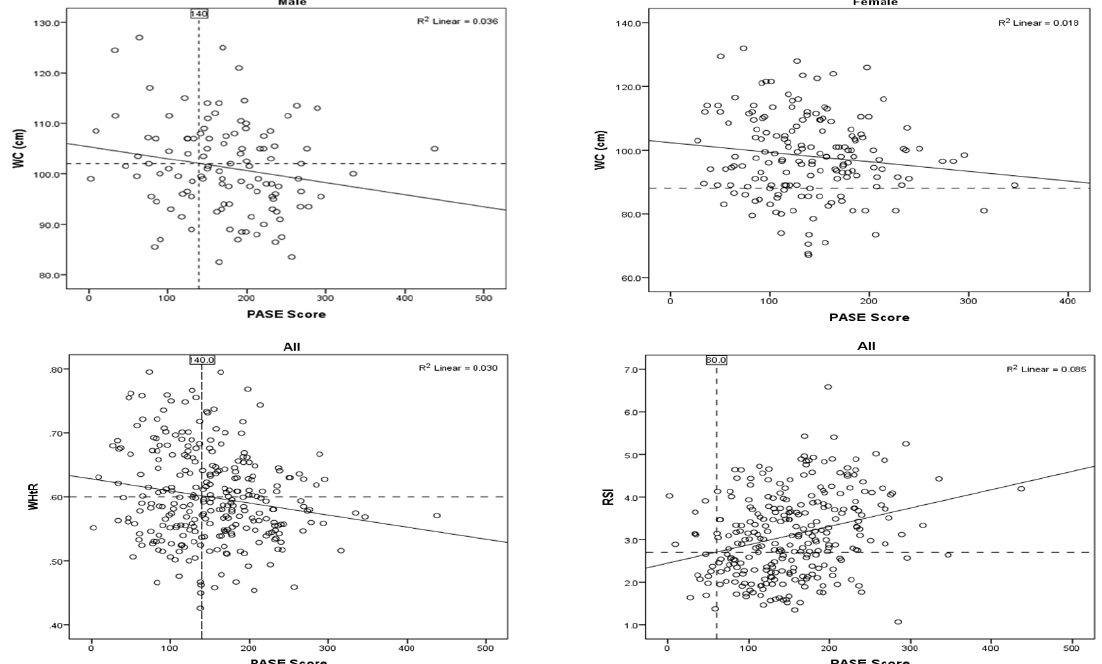
Figure 3. Scatter plots and regression lines of the correlation between health parameters and PASE score ( a ) for all participants and ( b ) separated by sex. The intersection of the health parameter cut-point and regression line produced the corresponding PASE score